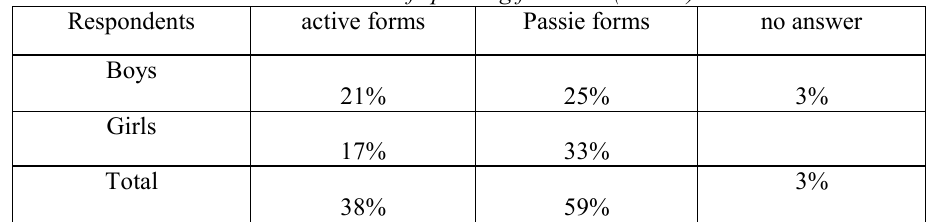
Table 1. Form of spending free time (n=229)